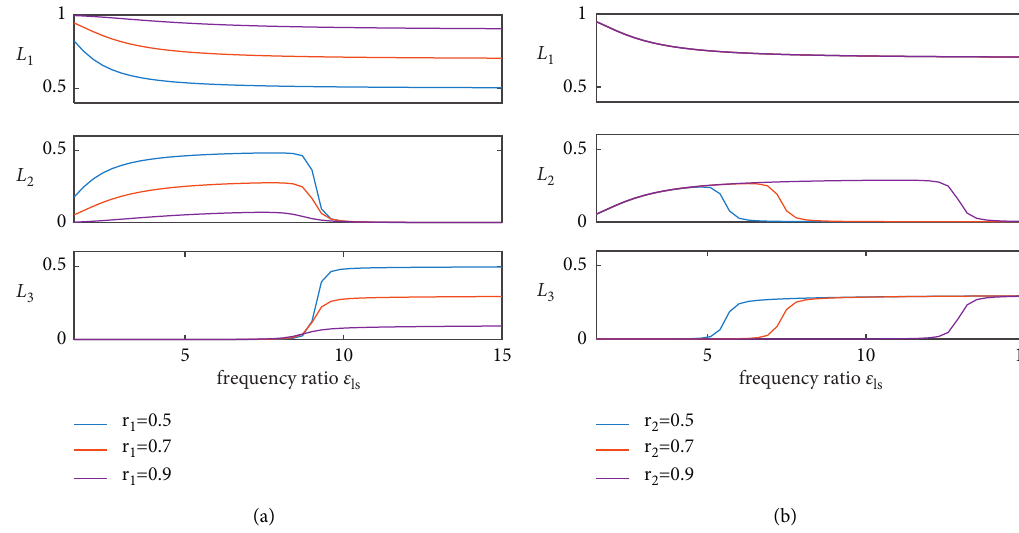
Figure 3: Modal participating mass ratios with various ε